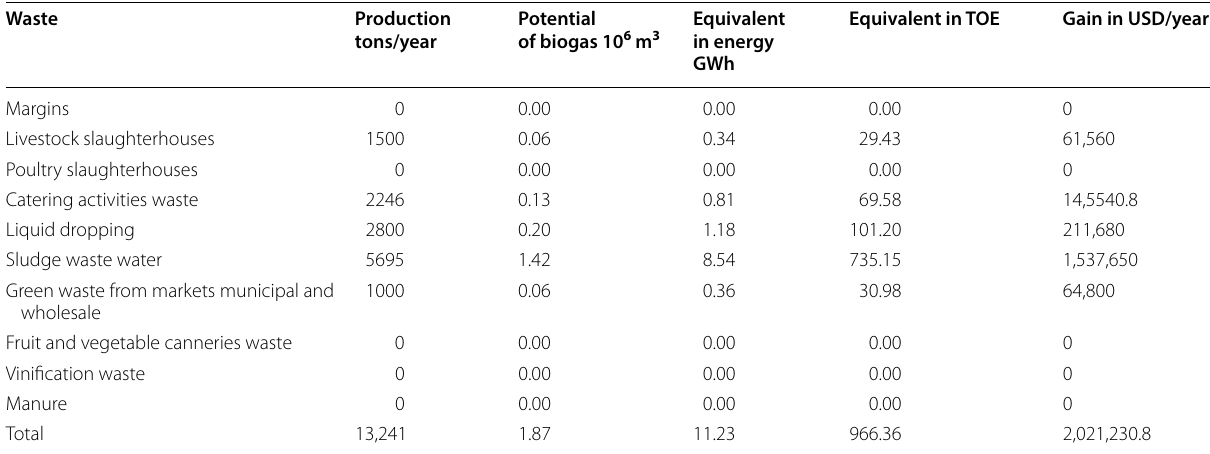
Table 8 Potential of Biogas in the Southwest of Tunisia